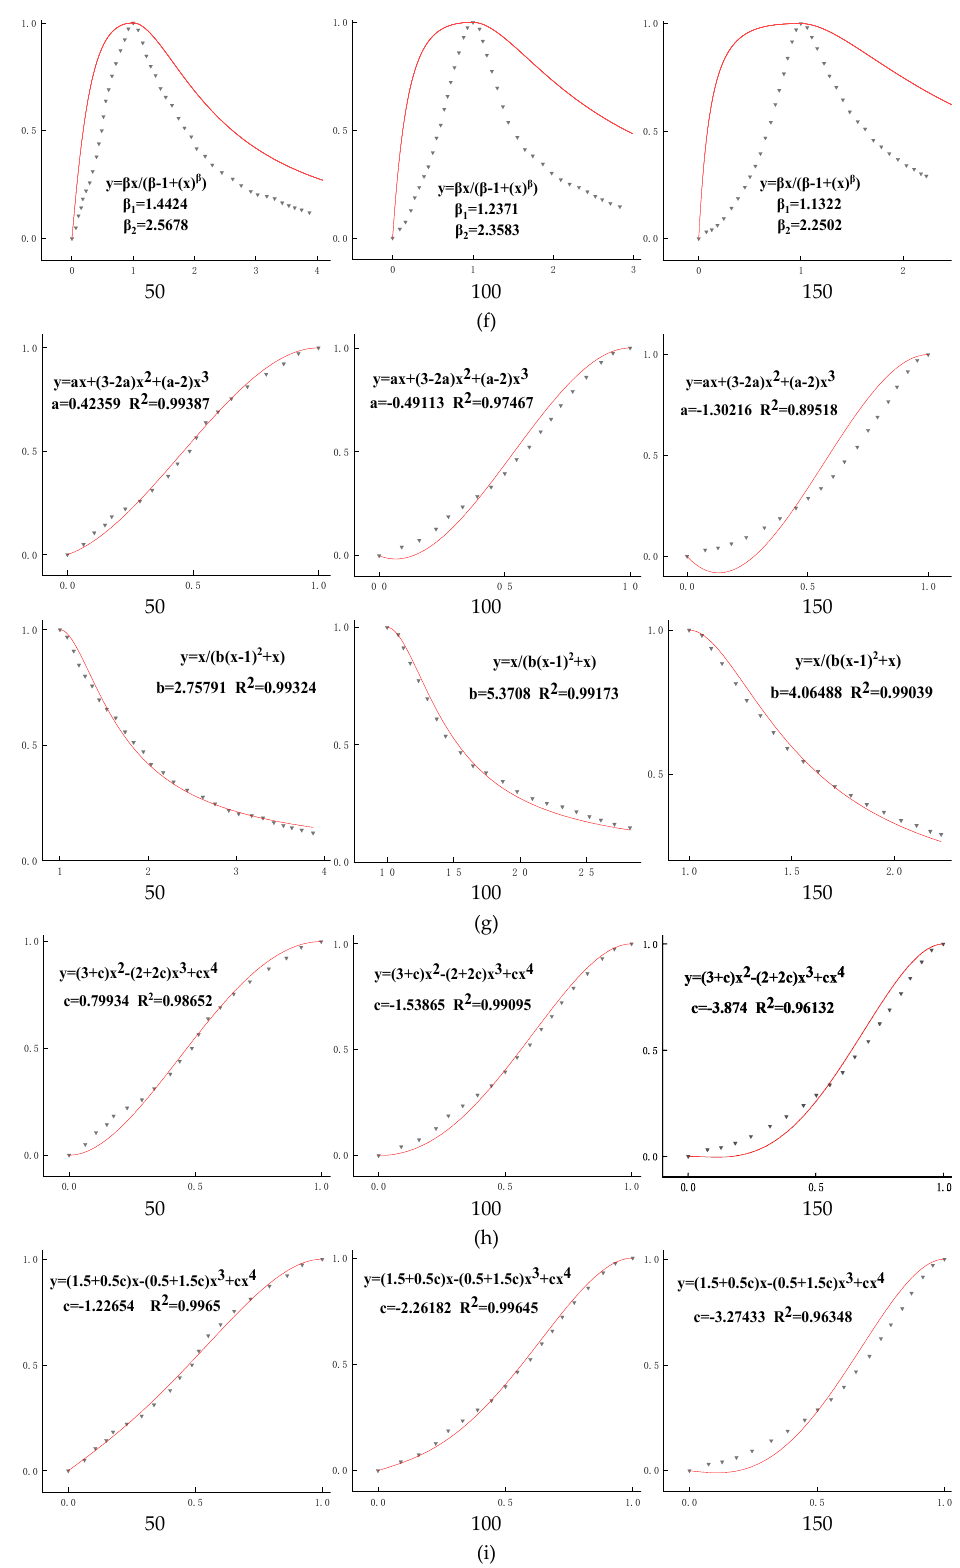
Figure 5. Fitting results of constitutive model of freeze–thaw concrete: ( a ) reference [19]; (b) reference [20]; (c) reference [21]; (d) reference [21]; (e) reference [22]; (f) reference [23]; (g) reference [17]; ( h ) the new model one; ( i ) the new model two; ( j ) the new model three; 50, 100, and 150 are numbers of freeze–thaw